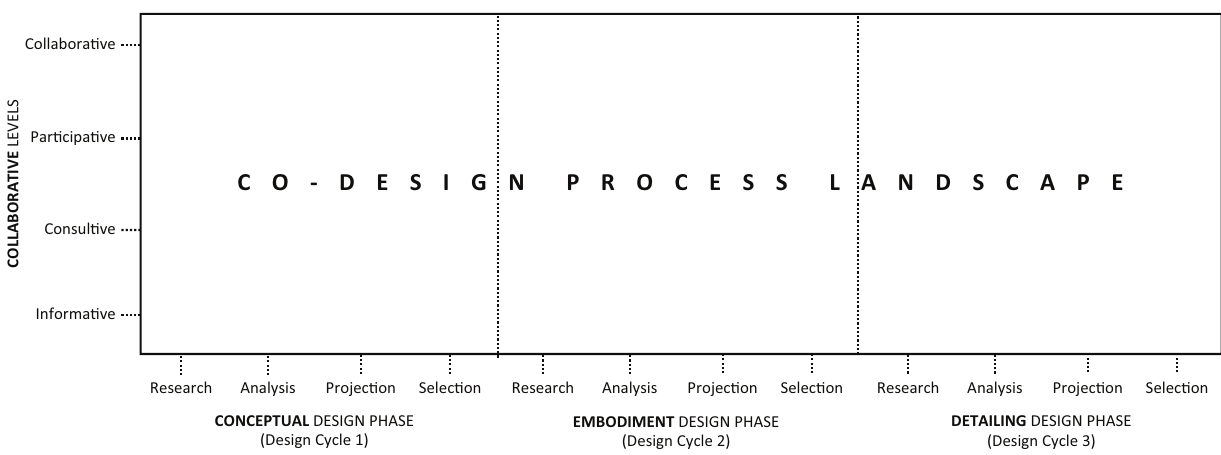
Figure 1. Framework for the urban co‐design process. Levels of collaboration on the Y‐axis and the design acts throughout the design phases on the X‐axis.